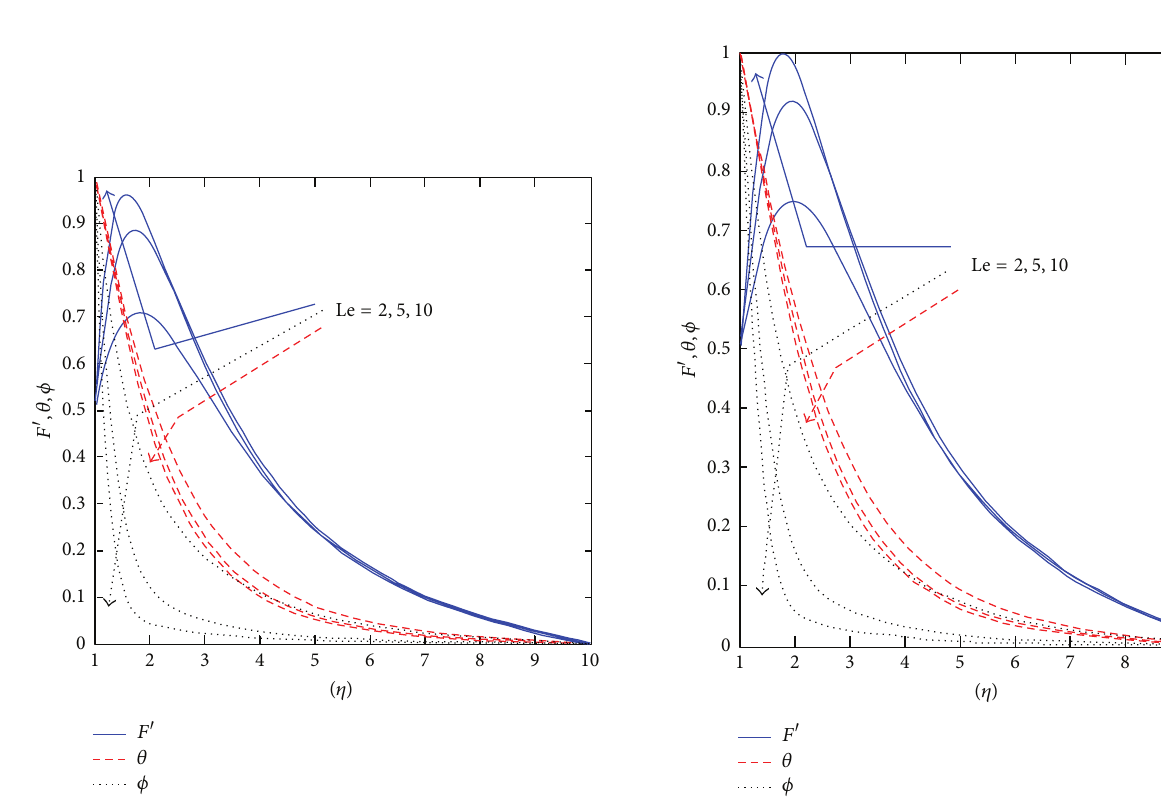
Figure 5: Plots of dimensionless similarity functions 𝐹 󸀠 (𝜂) , 𝜃(𝜂) , and 𝜙(𝜂) for various values of Le at Nr = 0.5, Nb = 0.5, Nt = 0.5, and 𝜁 = 0